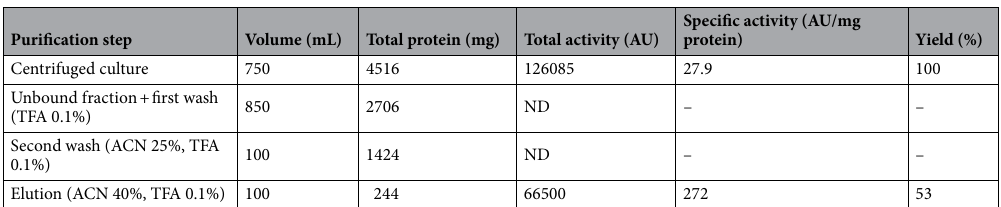
Table 1. Purification table of Sakacin-A-containing preparation. Data are representative for a single chromatographic procedure. ND not detected.